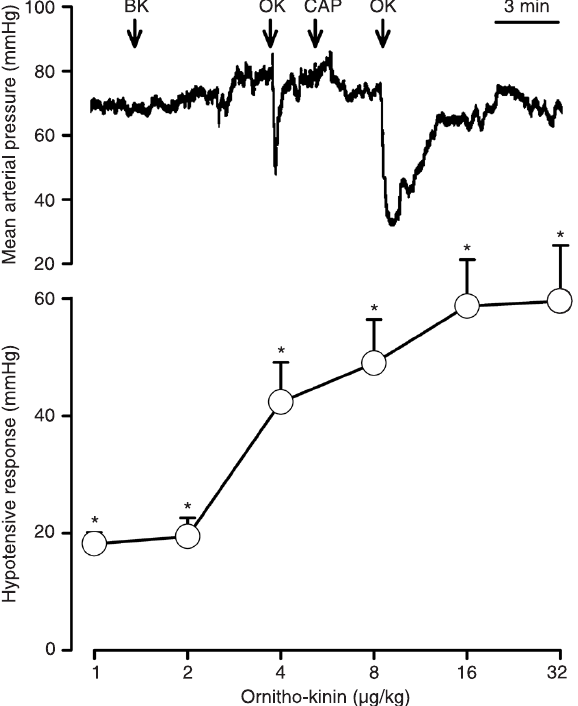
Figure 1. Effect of iv injected ornitho-kinin on arterial pressure in the anesthetized chicken. Top , typical example. BK = bradykinin, 20 µg/kg; OK = ornitho-kinin, 1 µg/kg; CAP = captopril, 0.1 mg/ kg, iv . Bottom , group data. Data are reported as means ± SEM for 6 animals each dose. * P < 0.05 vs no ornitho-kinin (ANOVA followed by the paired t